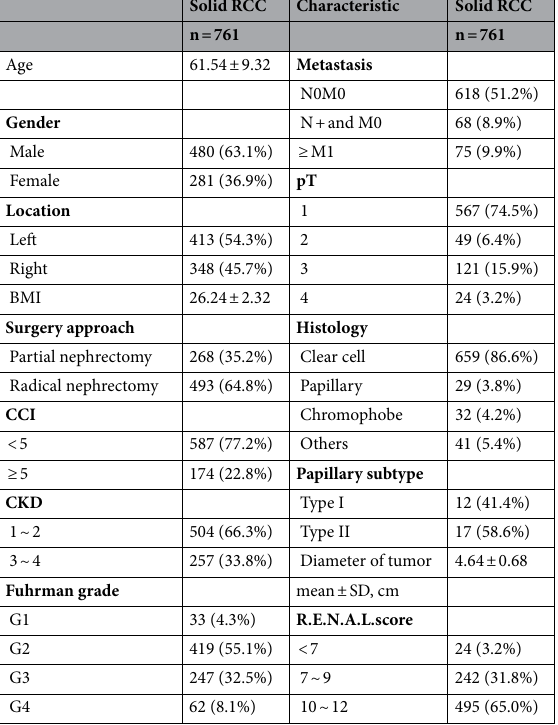
Table 3. Characteristics of 761 patients with solid renal cell carcinoma.